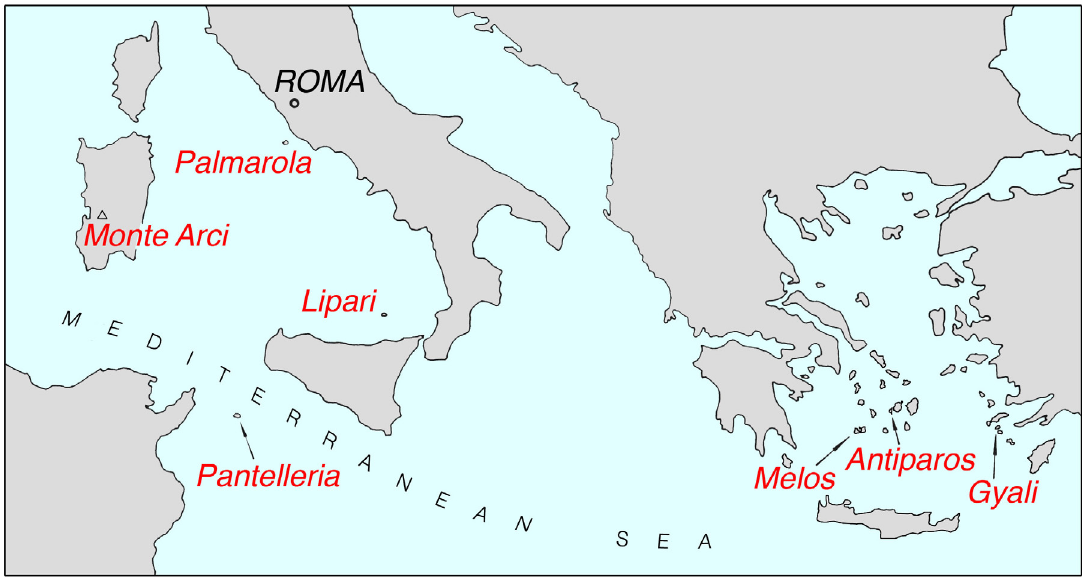
Figure 1. Obsidian source areas of the Mediterranean